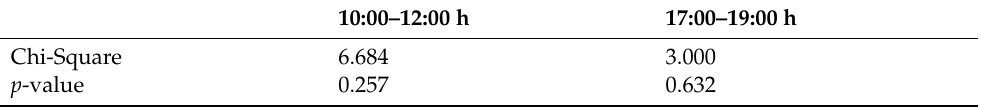
Table 12. Difference in magnetic flux density measurements across locations (Kruskal Wallis